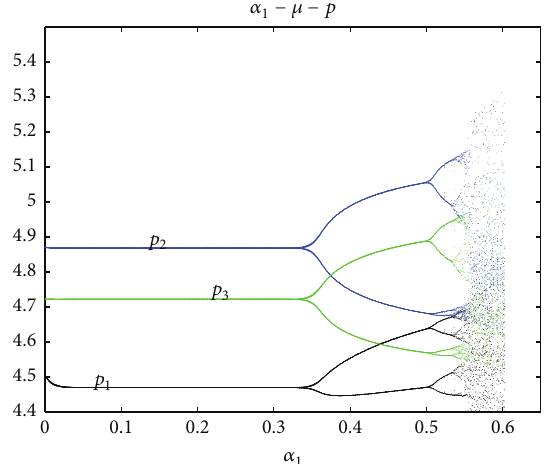
Figure 16: Track of 𝑝 𝑖 with 𝛼 1 after adjustment.